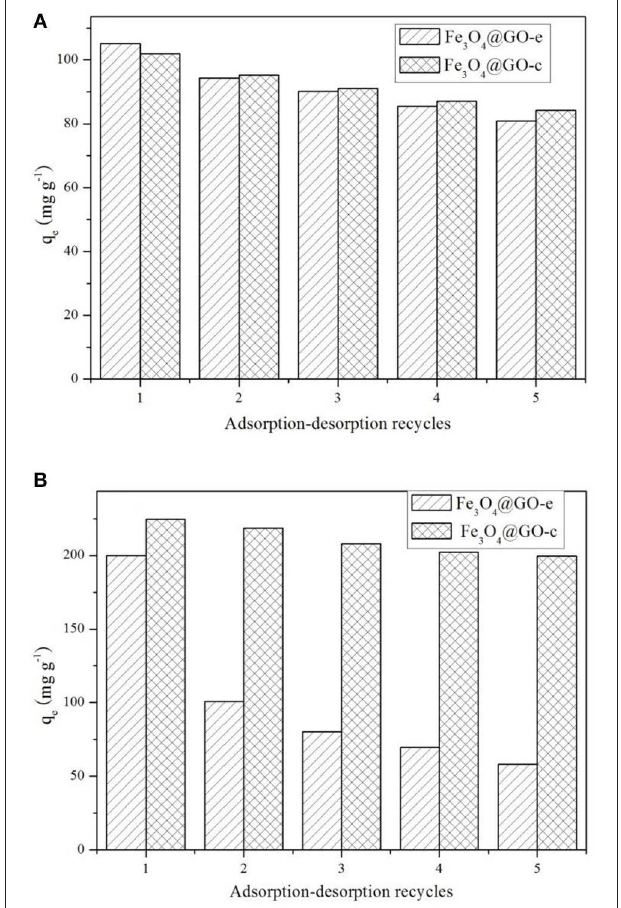
FIGURE 5 | Adsorption-desorption recycling tests toward (A) MB and (B) Pb(II).